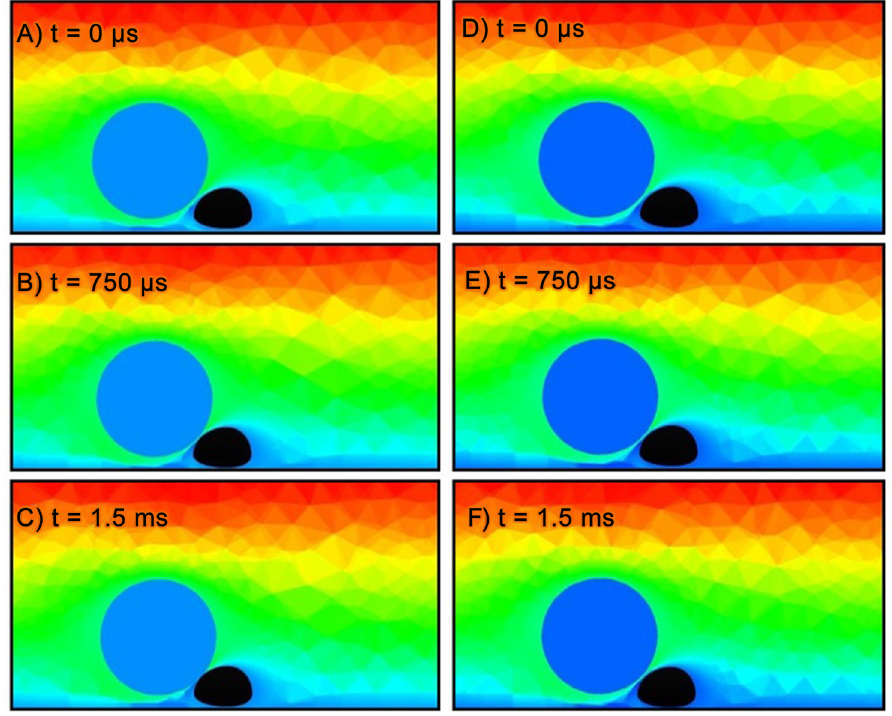
Fig 3. Comparison of CFD results using same initial parameters, with and without repulsion. (a-c) show results for the CFD simulation without the cellular repulsion. Without repulsion, the bodies can collide and cause the CFD solver to crash. When a collision occurs, as shown in (c), the CFD may produce non- physical results or be unable to reach a converged solution. (d-f) show results for CFD simulation with cellular repulsion activated. In this case, the bodies do not collide and the simulation continues to advance in time. Note: results are 2D cross-sections of fully 3D simulations. Flow from left to right. Contours are normalized velocity magnitude (blue = 0, red = 1). PMN is colored in black and melanoma cell is colored in